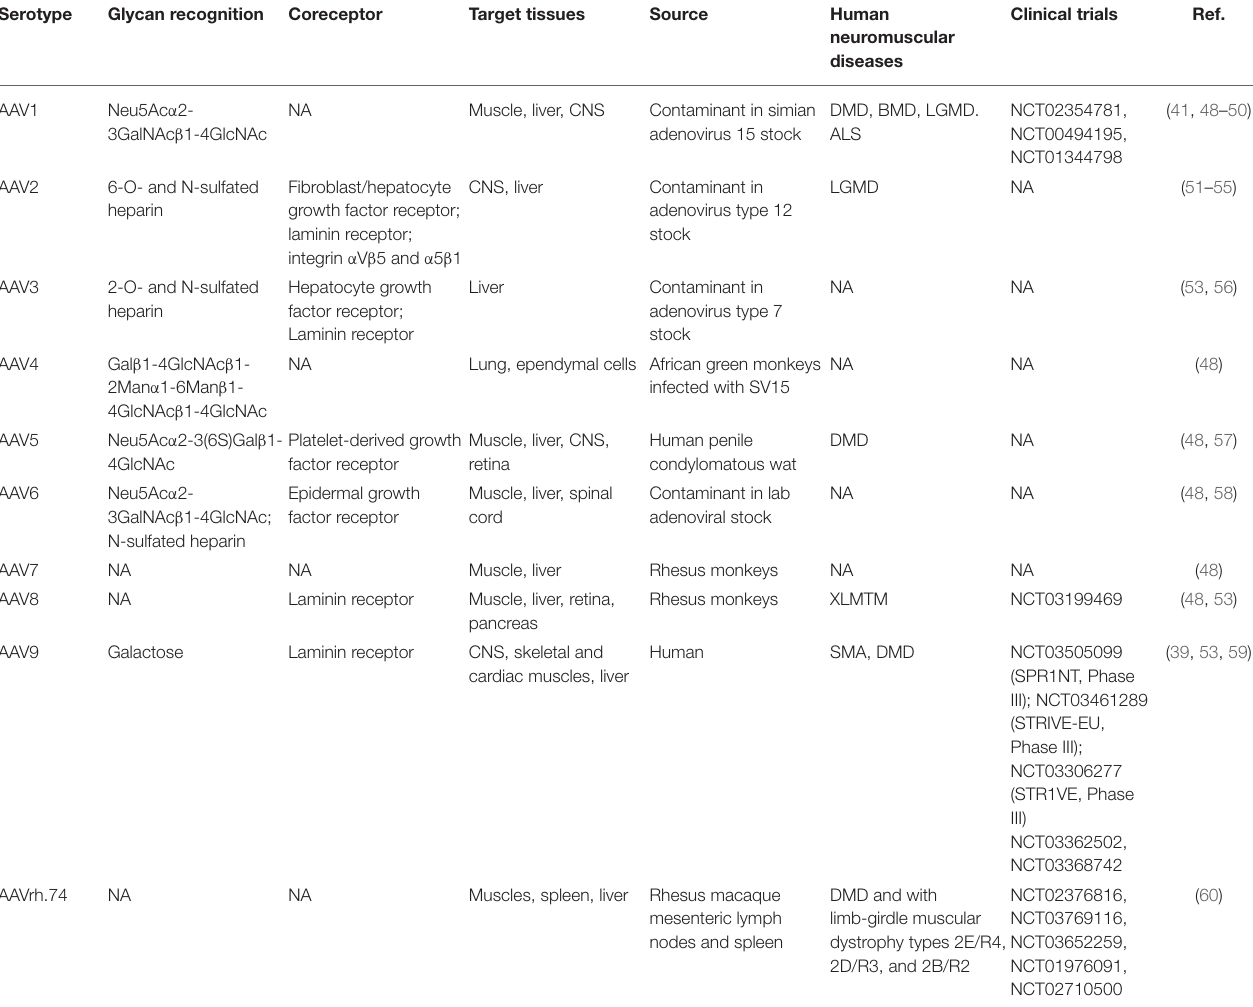
TABLE 1 | List of AAV serotypes used for gene therapy in neuromuscular disorders.